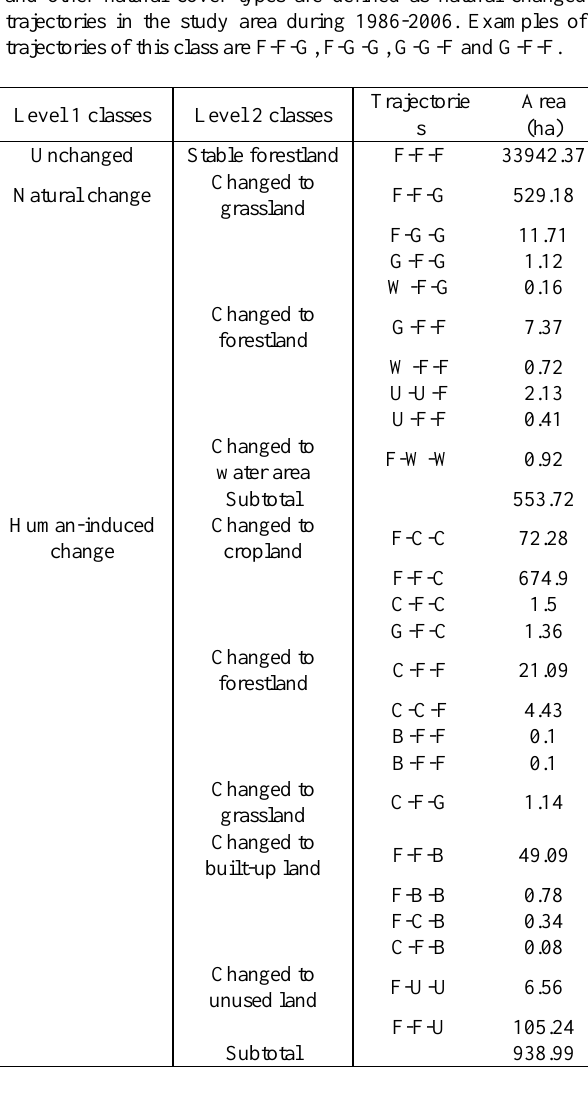
Table 2. Forest change trajectories and area statistics (km 2